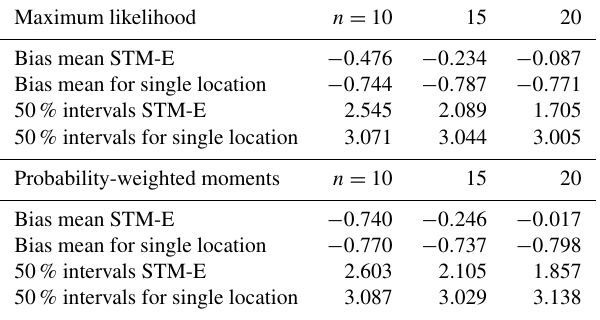
Table 2. Performance of STM-E and single-location analysis in es- timation of the bias and uncertainty of the 100-year return value, relative to empirical estimates from the full synthetic cyclone data, for analysis samples of size of 10, 15, and 20 all extracted from the 50-year data set. Bias B is assessed as the average difference (over the iso-depth contour and line transect analyses) between the mean STM-E (or single-location) estimate and return value esti- mated from the full cyclone data. Similarly, uncertainty U is as- sessed in terms of the average width of the 50% uncertainty band of the STM-E (or single-location)